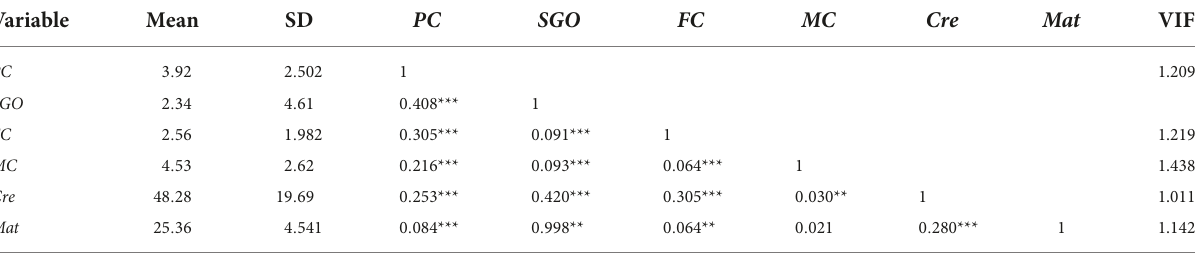
TABLE 3 Descriptive statistics and correlation